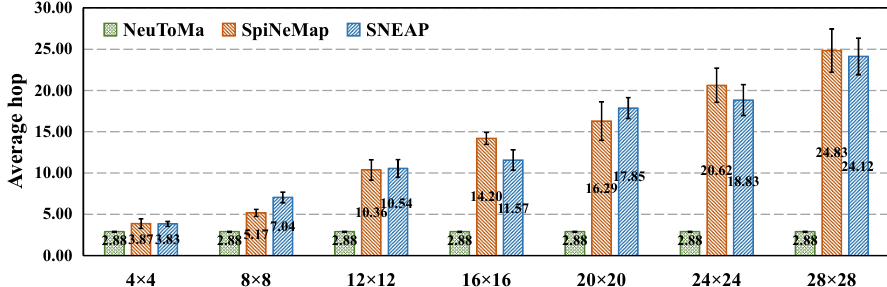
Figure 9. The average hop of spike messages obtained under different neuromorphic processor